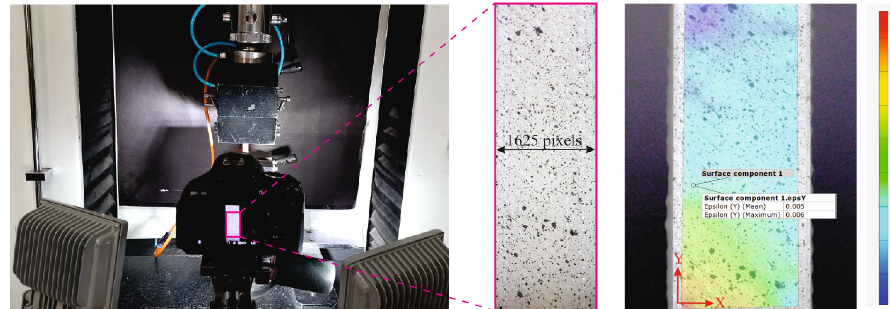
Figure 4. DIC setup including imaging and lighting